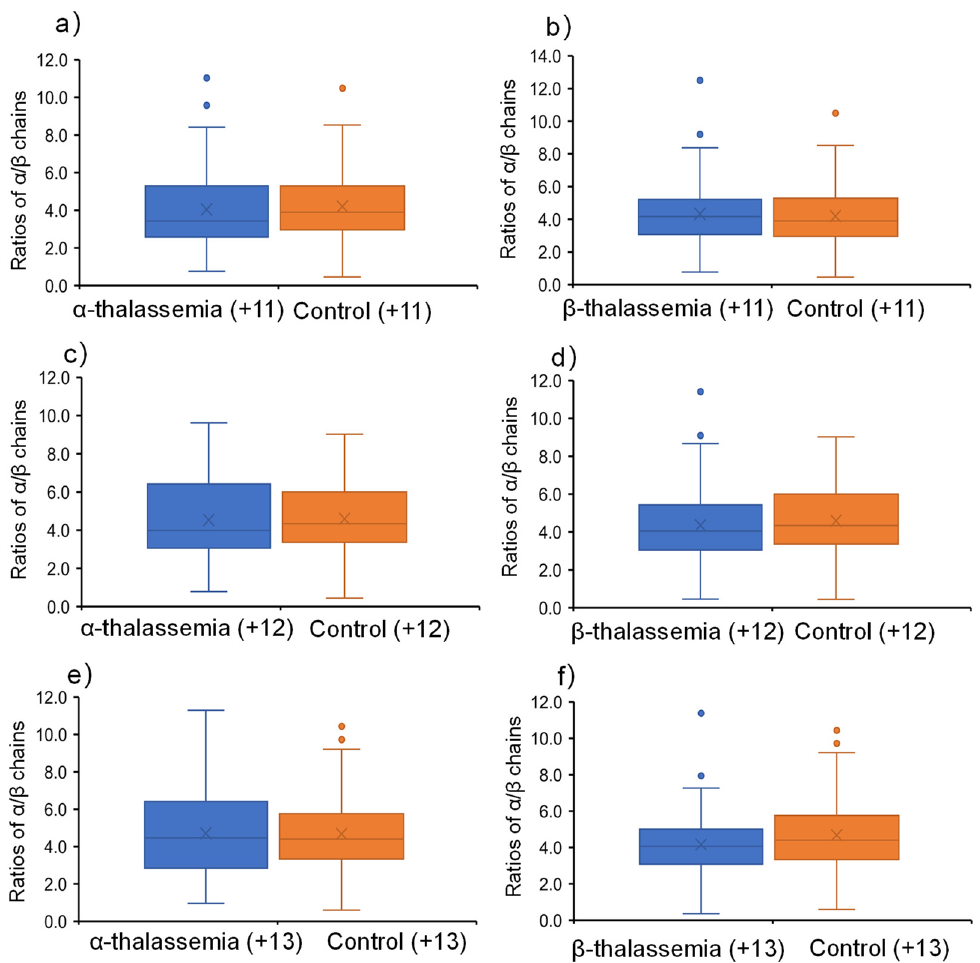
Figure 3. Ratios of Hb α‐ / β‐ chains from α‐ / β‐ thalassemia to healthly whole blood samples by wooden ‐ tip ESI ‐ MS under different charged states: ( a ) α‐ thalassemia (+11), ( b ) β‐ thalassemia (+11), ( c ) α‐ thalassemia (+12), ( d ) β‐ thalassemia (+12), ( e ) α‐ thalassemia (+13), and ( f ) β‐ thalassemia (+13).